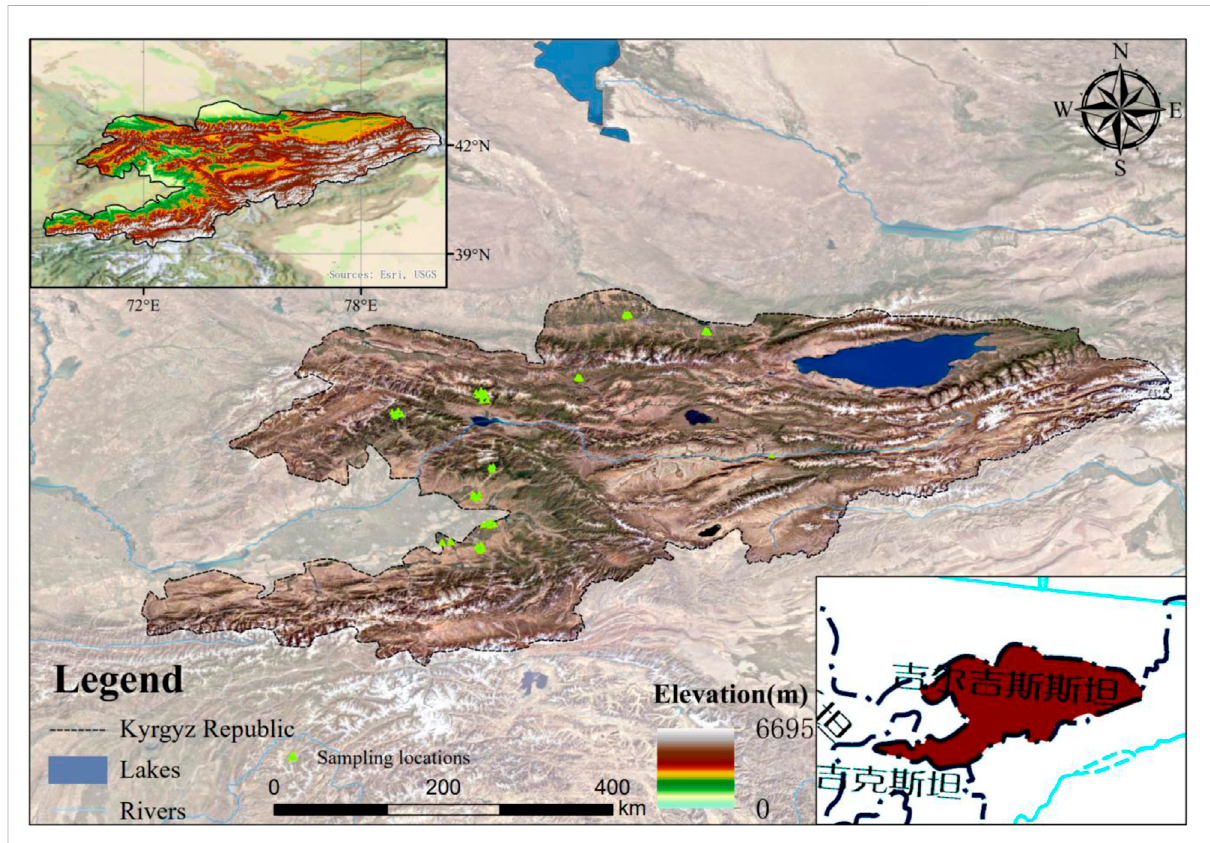
FIGURE 1 Overview of the study area. The map is based on the standard map No. GS (2021)5453 downloaded from the map technology review center of Ministry of natural resources, the standard map is not modi fi